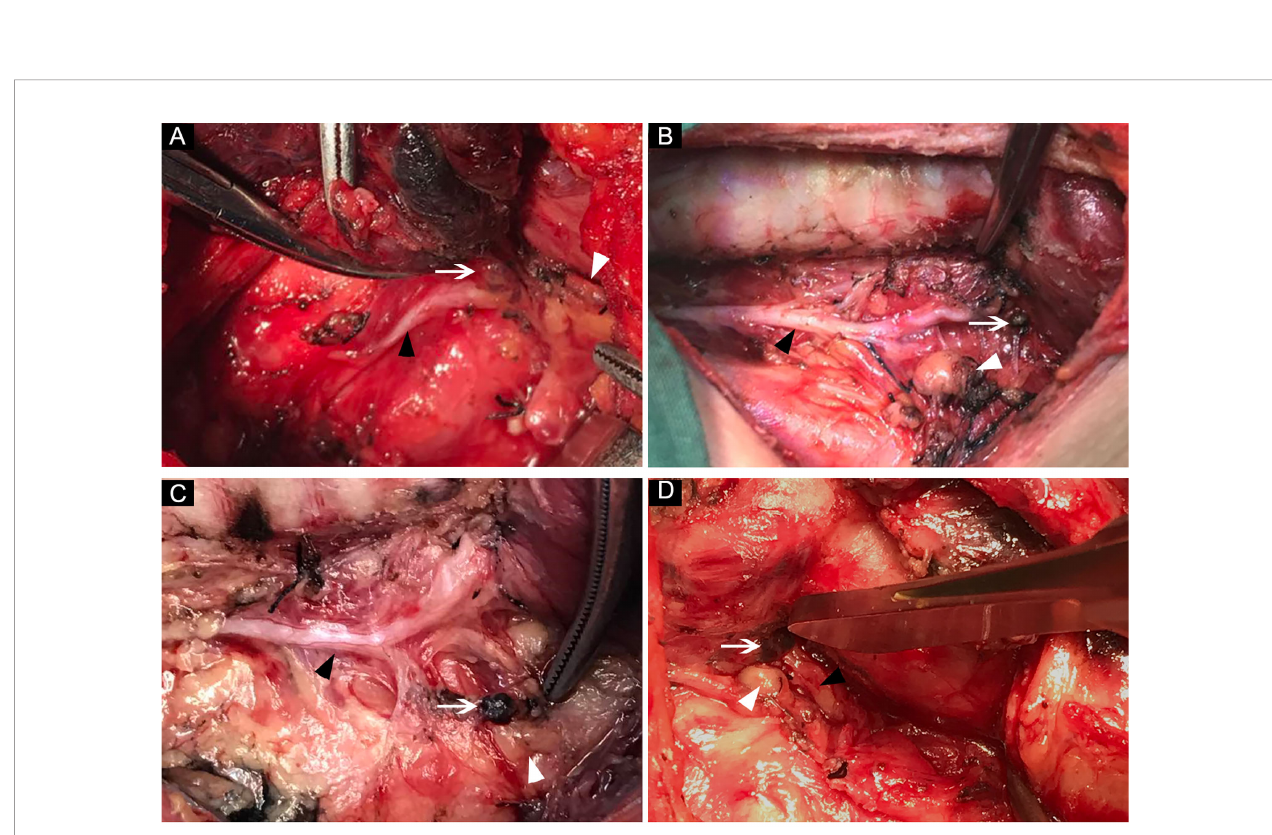
FIGURE 3 | The common locations of lymph nodes in RLNIZ. (A) Lymph node located medially to the RLN inlet; (B) small lymph node located laterally to the RLN inlet; (C) lymph node located far from RLN inlet due the traction; (D) lymph node and SPG located closely to each other at RLNIZ. White arrow: lymph nodes in RLNIZ; black arrow head: RLN; white arrowhead: superior parathyroid gland. RLNIZ, recurrent laryngeal nerve inlet zone; RLN, recurrent laryngeal nerve; SPG, superior parathyroid